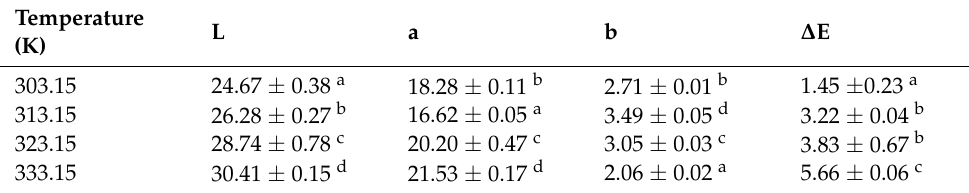
Table 5. Effect of drying temperature on color parameters of Kyoho skin powder 1.